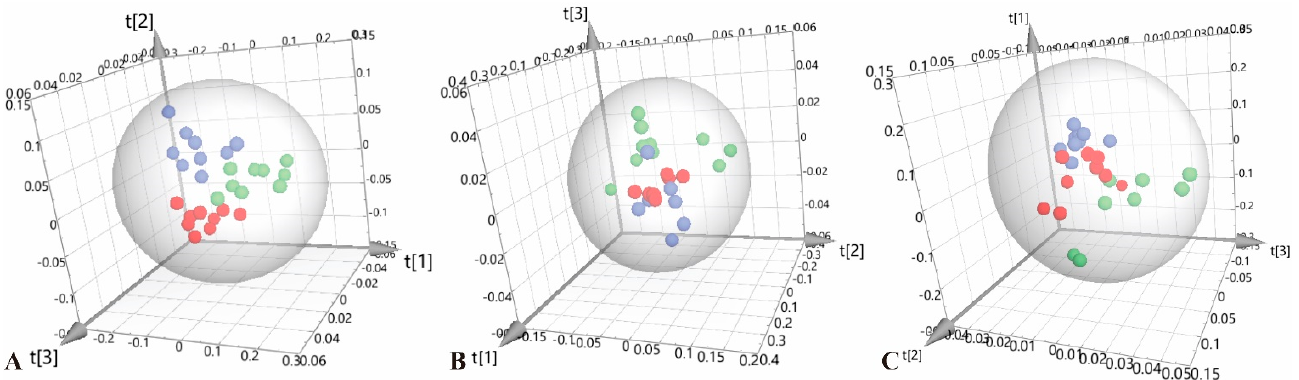
Figure 2. PCA scores plots for 1 H-NMR spectra data. ( A ) 8 w, R 2 X = 0.937, Q 2 = 0.904; ( B ) 8 + 4 w, R 2 X = 0.940, Q 2 = 0.802; ( C ) 8 + 8 w, R 2 X = 0.955, Q 2 = 0.778. ● C57; ● ApoE − / − ; ● ApoE − / − ;SAP − / −